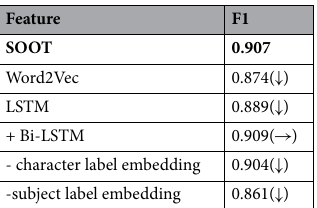
Table 4. Feature settings. Significant values are in [bold].